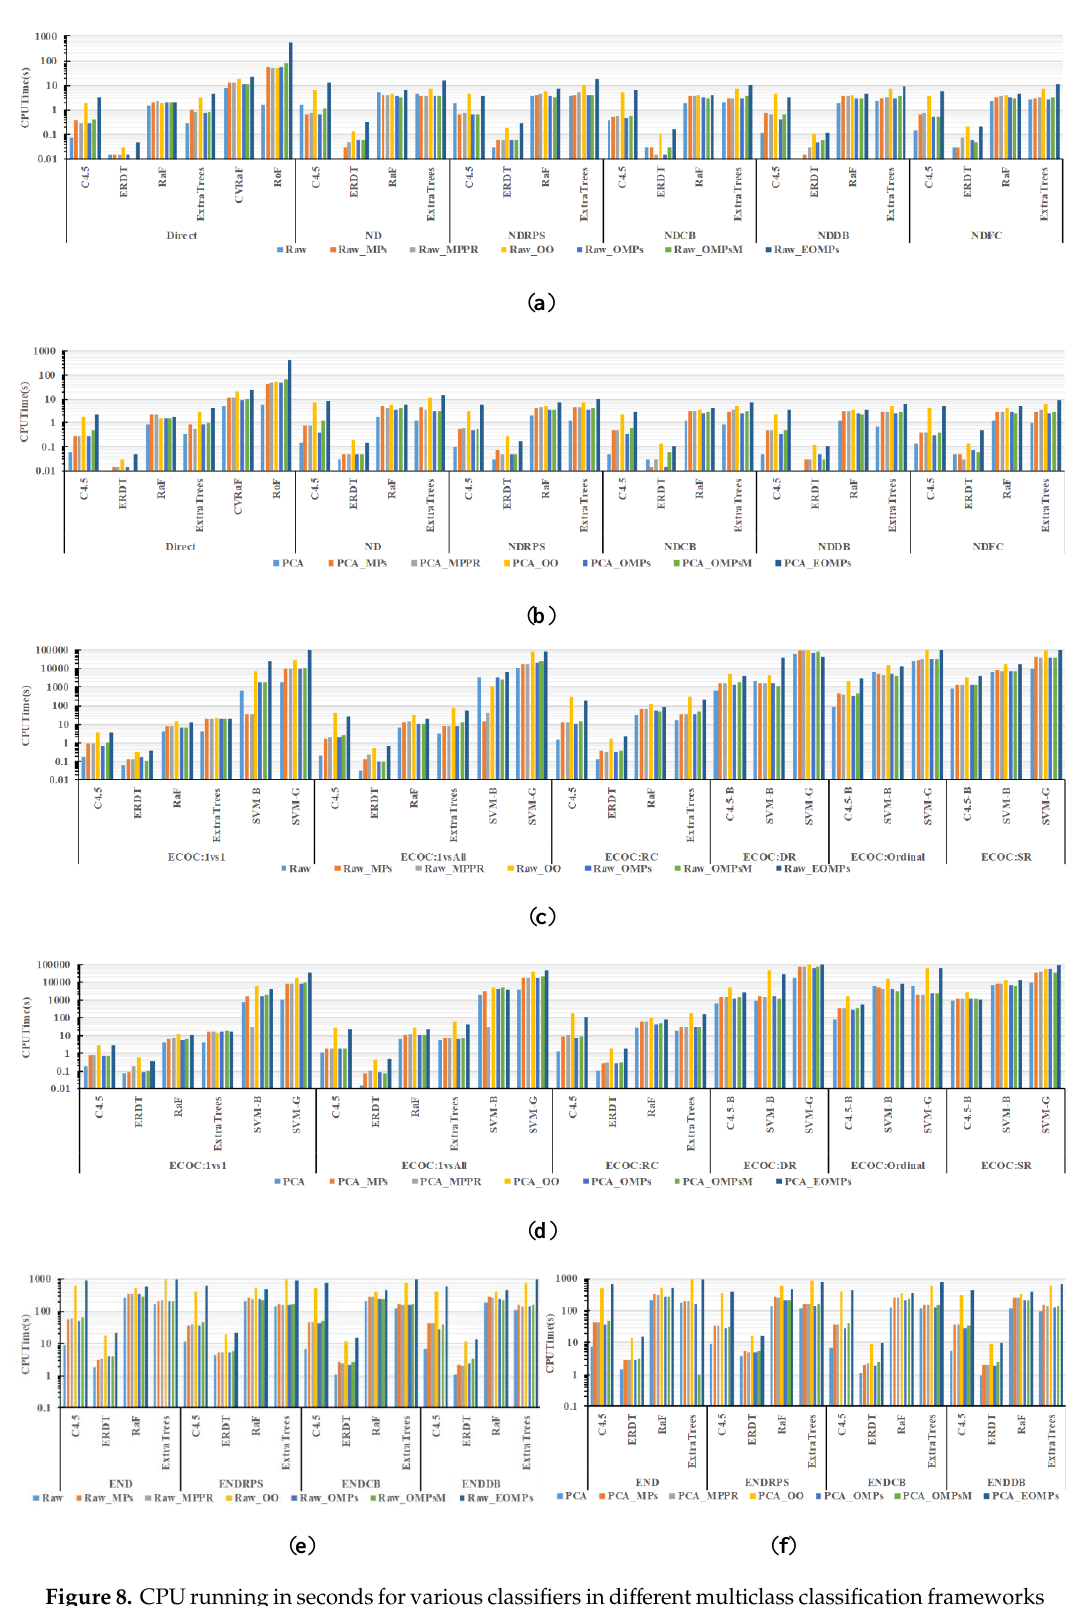
Figure 8. CPU running in seconds for various classifiers in different multiclass classification frameworks (Direct and ND: a, b; ECOC: c, d; END: e, f) using considered features.